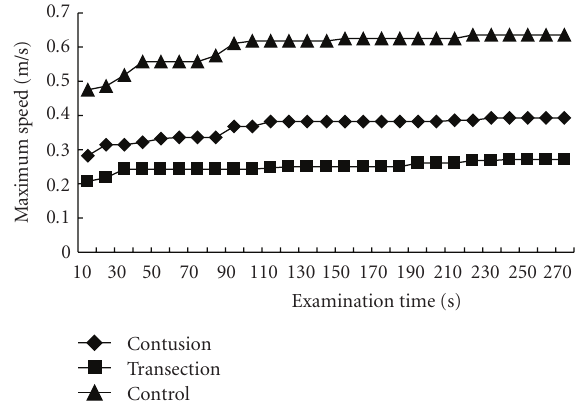
Figure 5: The maximum speed values to each time point were plotted with POD 42 data. They gradually increased and reached plateaus around 2min in all groups. More than 2 minutes of examination time yielded slight di ff